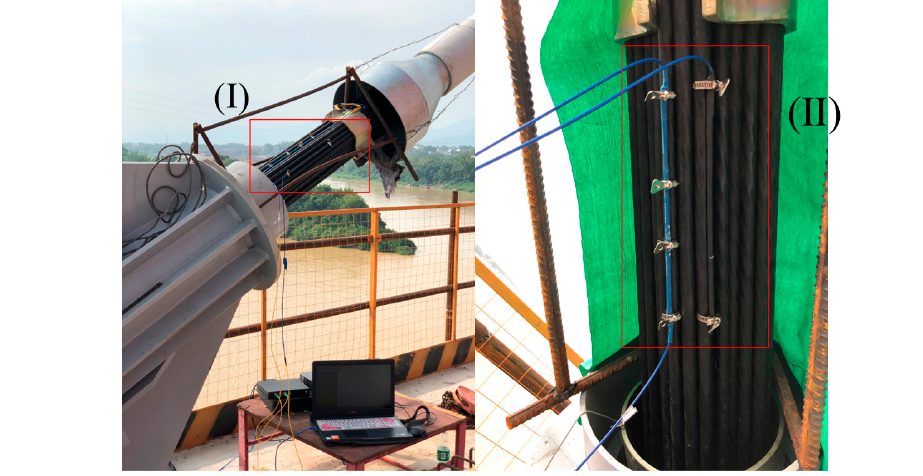
Figure 14. Position diagram of FBG thin rod vibration sensor.